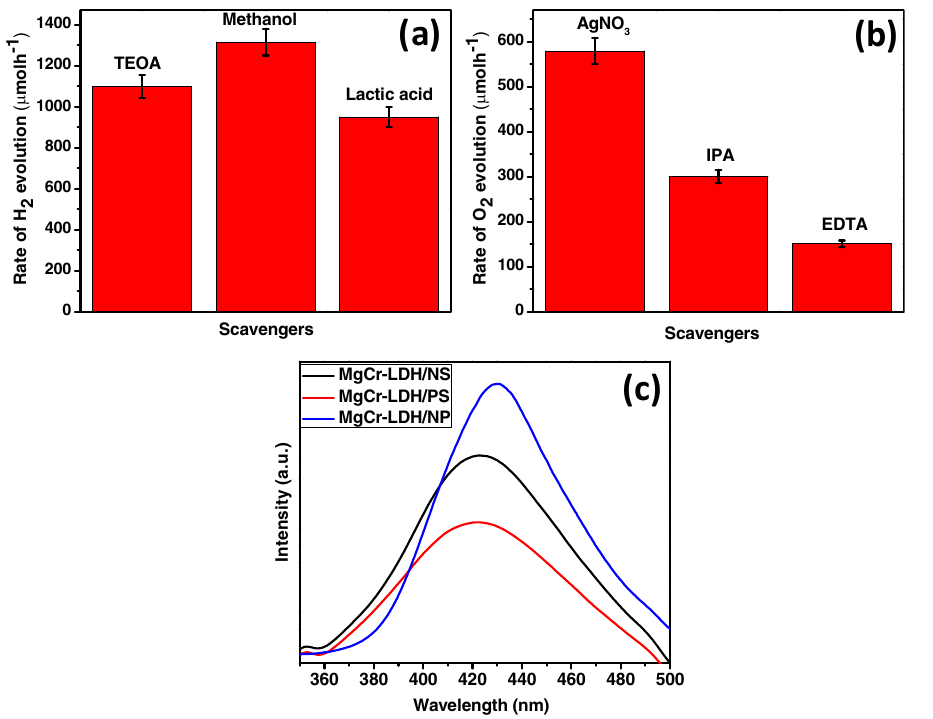
Figure 11. ( a , b ) Effect of different sacrificial agent on H 2 and O 2 evolution under visible light exposure, and ( c ) Hydroxyl radical test plot for all